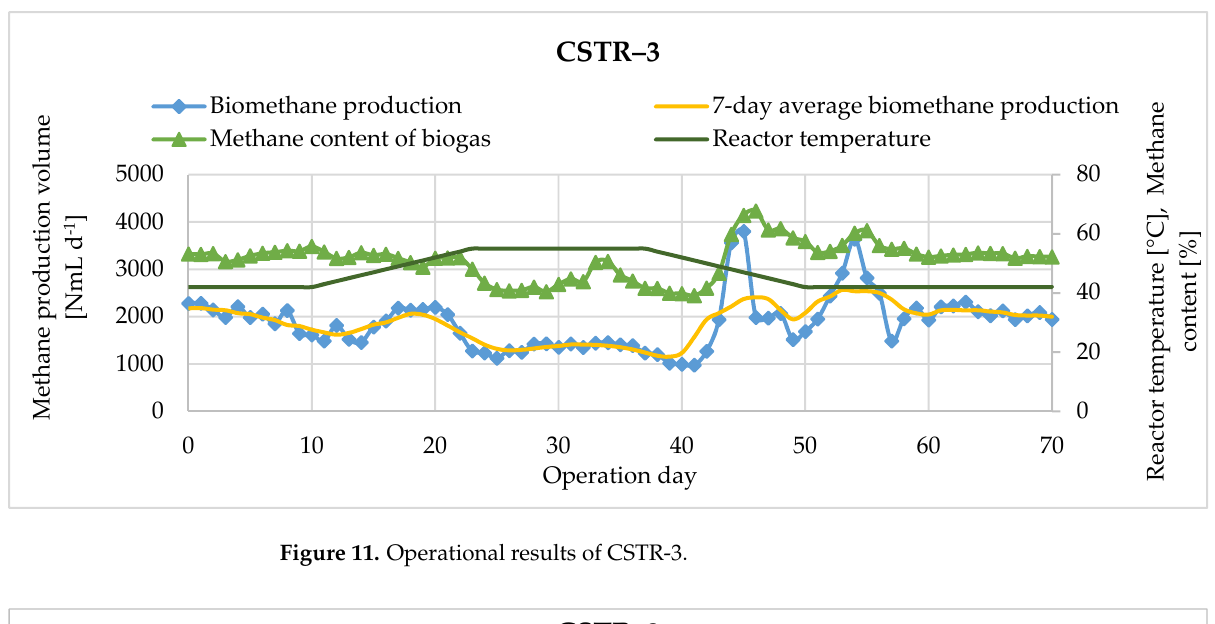
Figure 11. Operational results of CSTR-3.